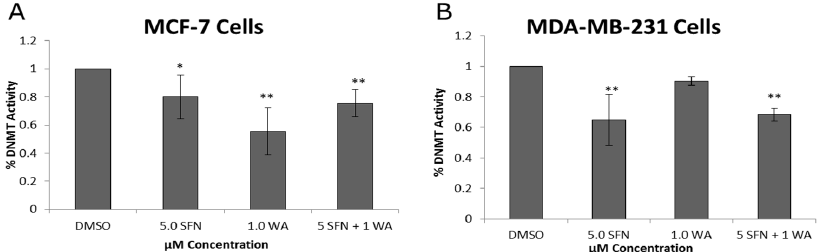
Figure 3. Combinatorial WA and SFN affect enzymatic activity of DNA methyltransferases (DNMTs).